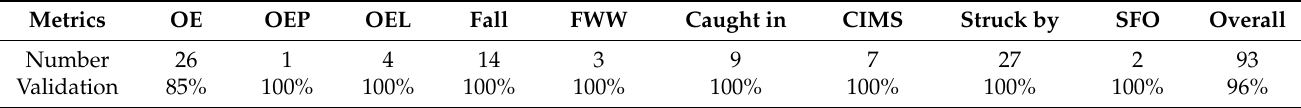
Table 7. Performance of RF models on non-MSHA